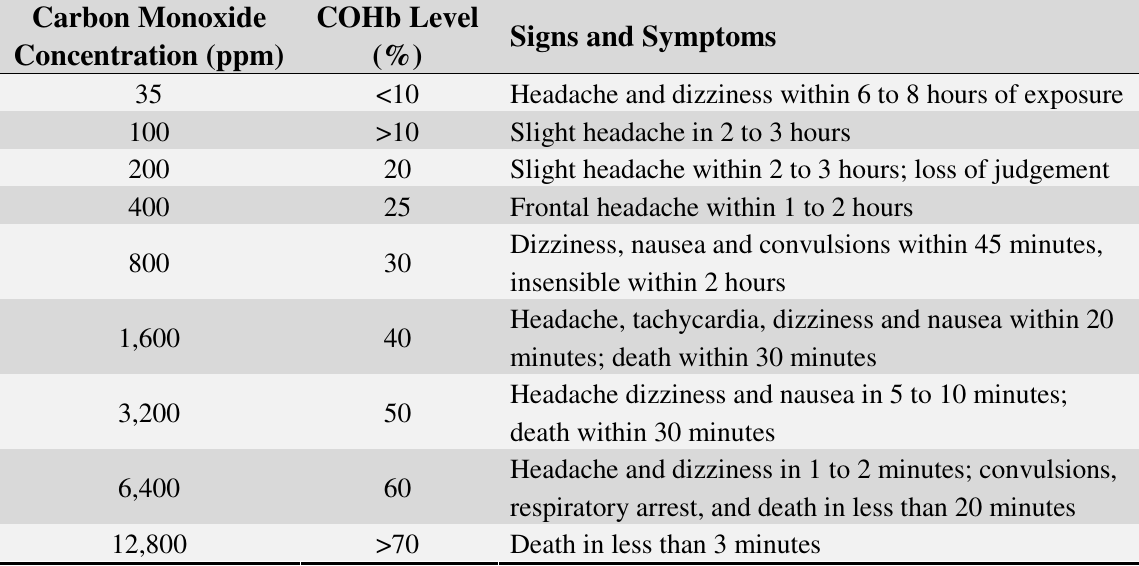
Table 2. Demonstrating the effects of certain concentrations of carbon monoxide on human health. COHb is the percentage of carbon monoxide in the blood. Typical concentrations in the home are 0.5–5 ppm (united states environmental protection